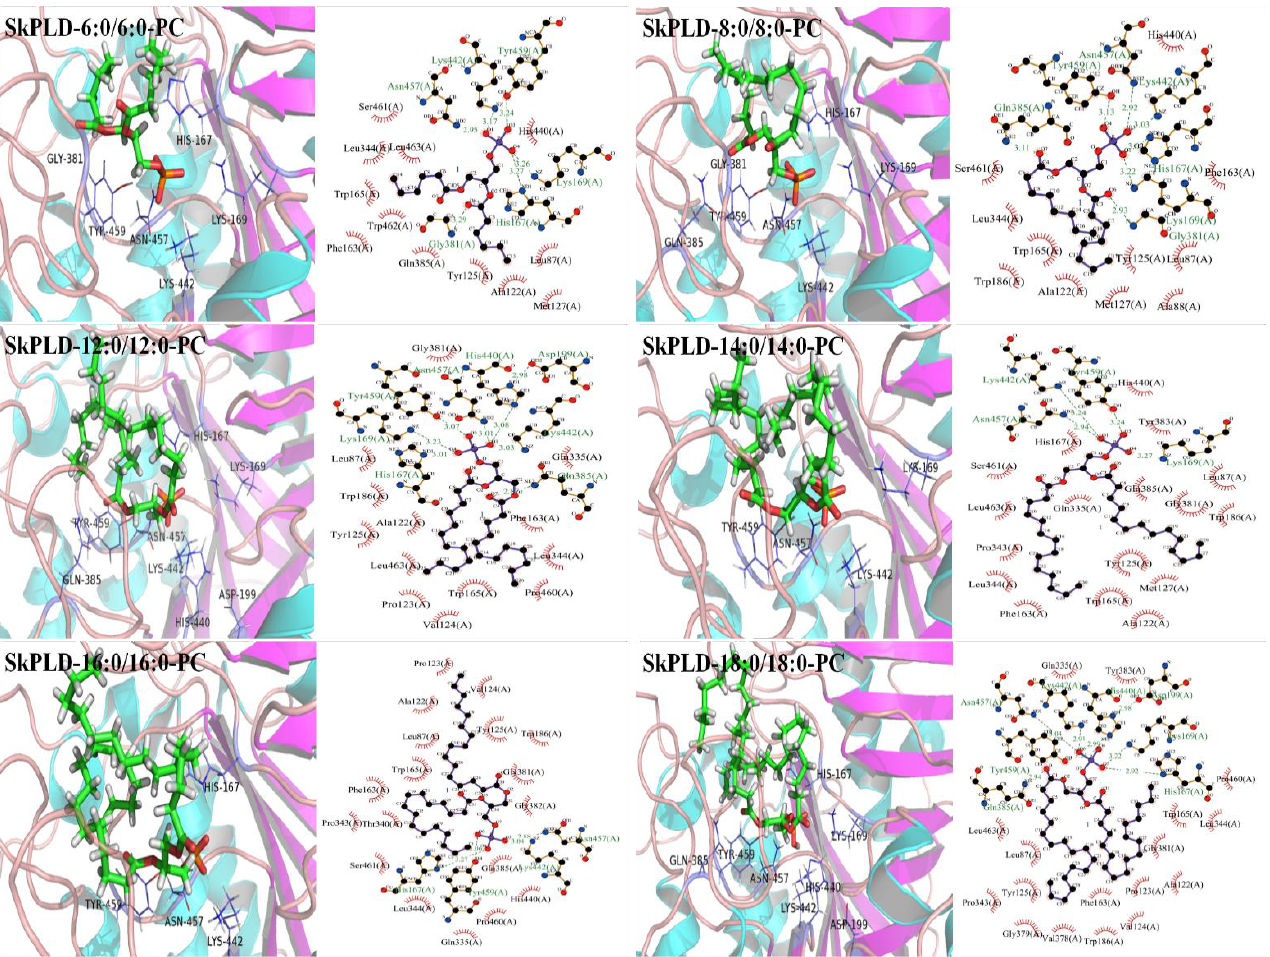
Figure 3. 3D ( left ) and 2D ( right ) structure of complexes of SkPLD and 6:0/6:0-PC, 8:0/8:0-PC, 12:0/12:0-PC, 14:0/14:0-PC, 16:0/16:0-PC and 18:0/18:0-PC. In the 2D diagram, hydrogen-bond interactions and hydrophobic contacts were shown as green and red dotted lines, respectively. Table 2. The estimated binding energy of SkPLD-PC complexes.